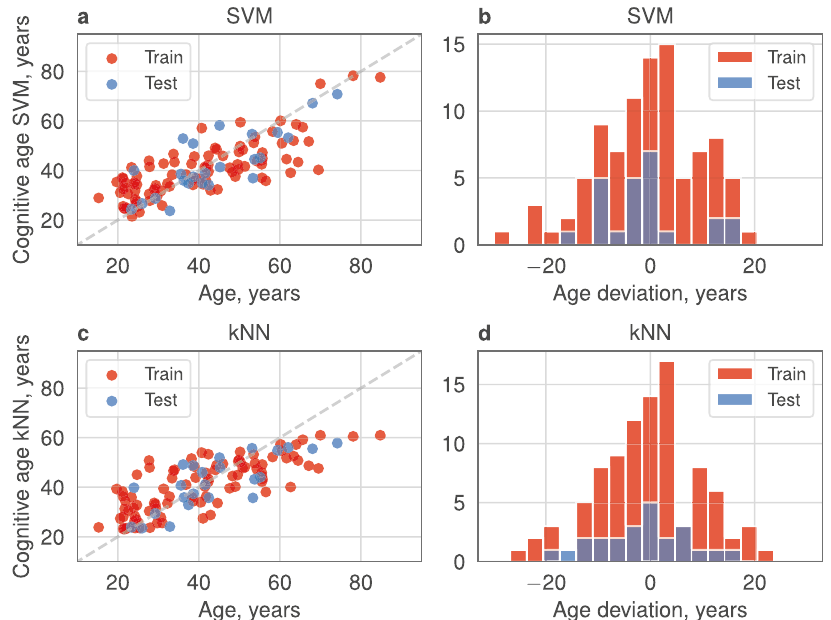
Fig. 4 Prediction results of Cognitive age by 2 optimal models: SVM and kNN. Panel rows corresponds to optimal models: SVM ( a , b ) and kNN ( c , d ). Left column ( a, c ): prediction of chronological age by models for train and test samples; black line corresponds to the diagonal of the fi rst quarter. Right column ( b , d ): distribution of age deviations of Cognitive clock. Test set selected as the fi rst 20% of the dataset and train set as the remaining subjects. Such partitions were used only for